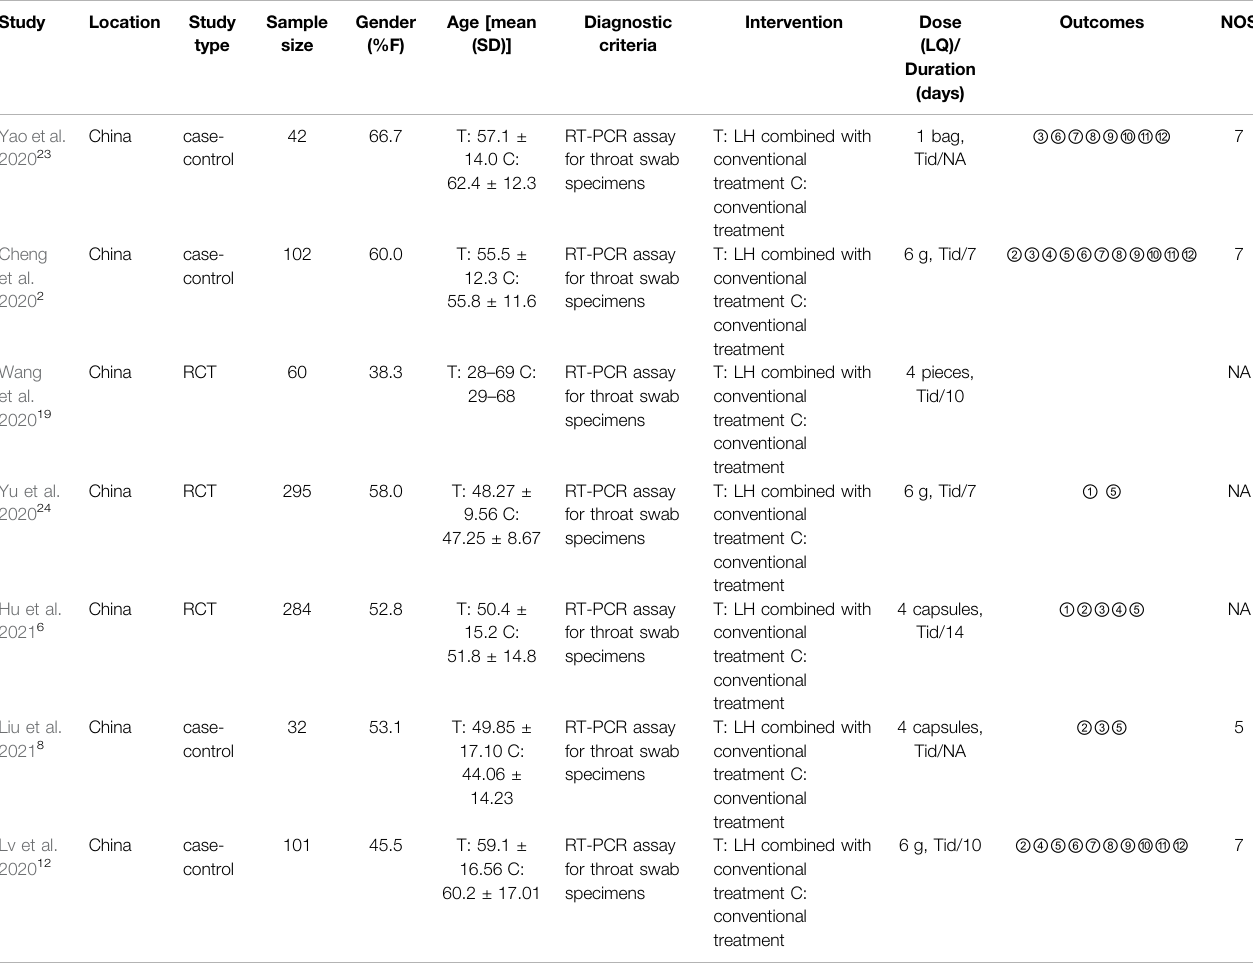
TABLE 1 | Description of included studies and patient characteristics.